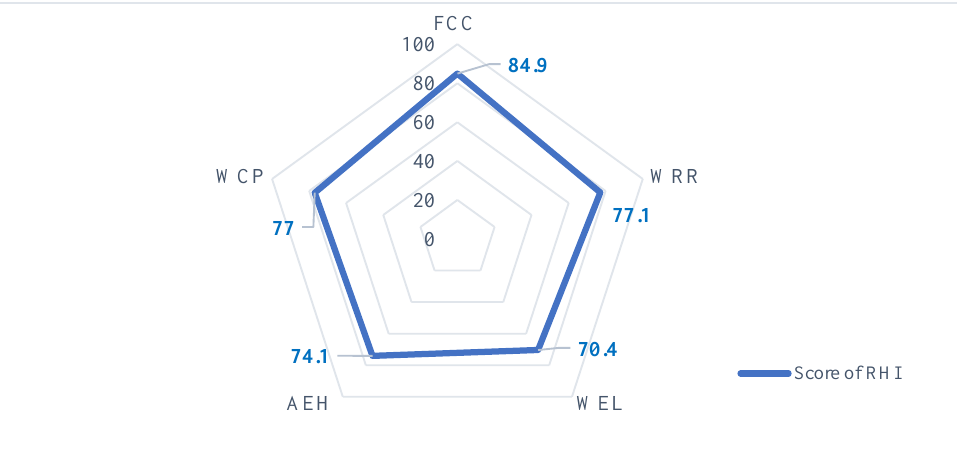
Figure 8. Evaluation results of the first-level indicators of the RHI in China.